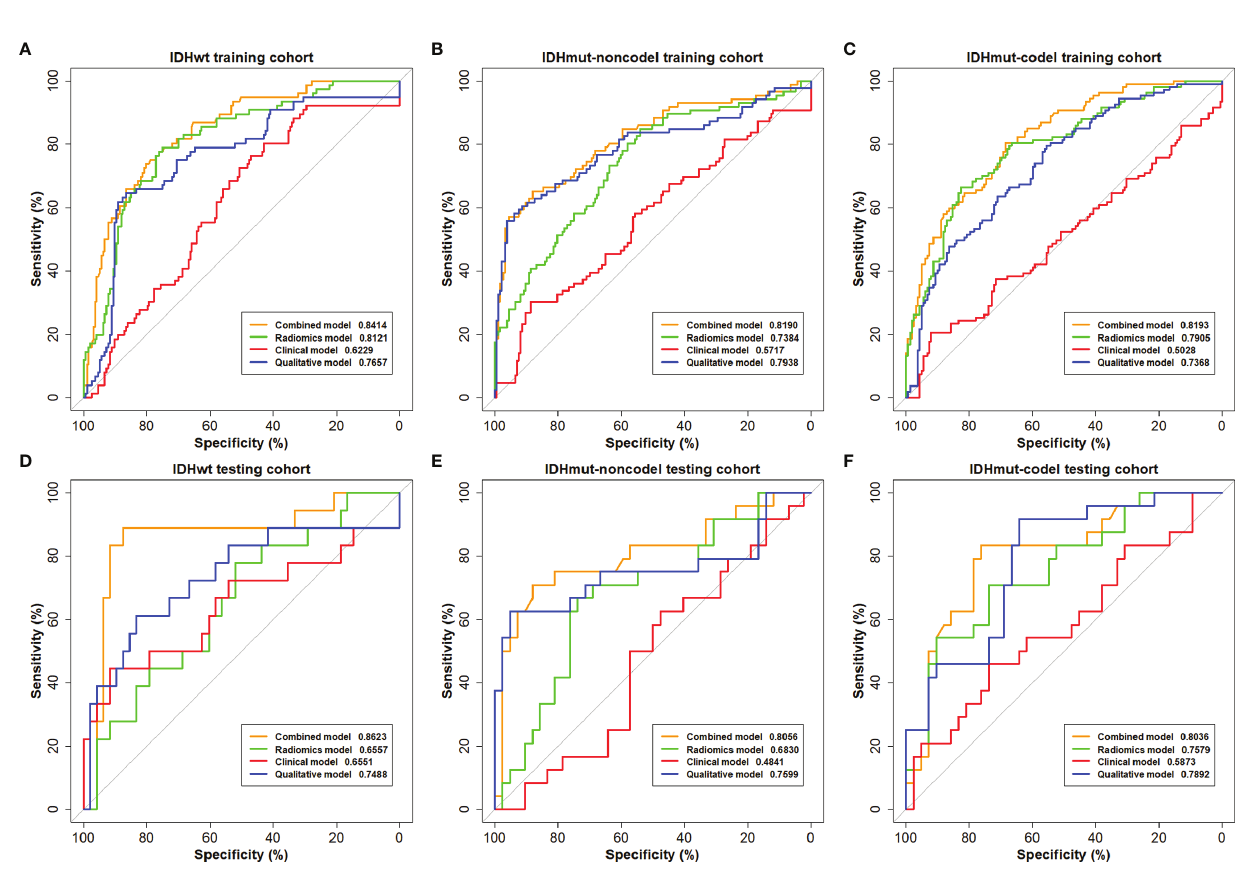
FIGURE 2 | The receiving operating characteristics (ROC) curves of the combined model, the radiomics model, the clinical model, and the qualitative model on the (A – C) training cohort and (D – F) testing